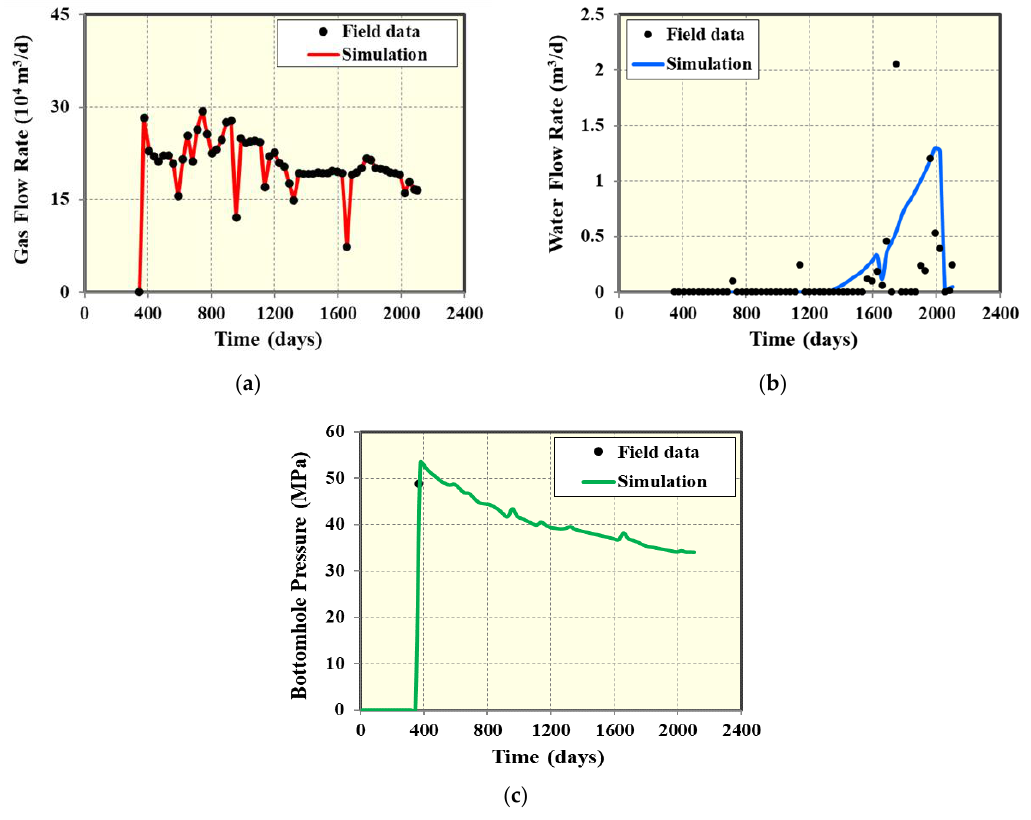
Figure 33. Single-well model simulation and history matching results of well B4. The points represent the field data while the solid lines represent the simulated values: ( a ) gas flow rate history matching results; ( b ) water flow rate history matching results; ( c ) BHP history matching results.